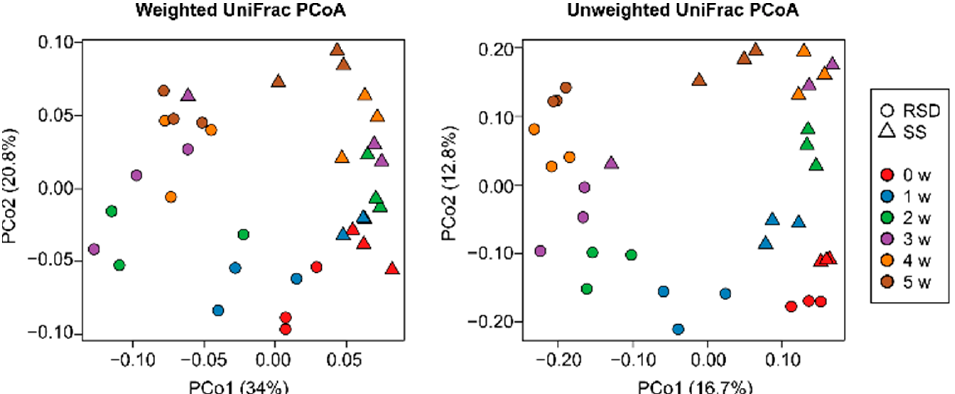
Figure 2. Weighted and Unweighted UniFrac-based principal coordinate analysis (PCoA) of the soil bacterial communities under ( ○ ) reductive soil disinfestation (RSD) and ( △ ) soil solarization (SS). Red, blue, green, purple, yellow, and brown denotes 0–5 w: treatment period for 0 to 5 weeks.